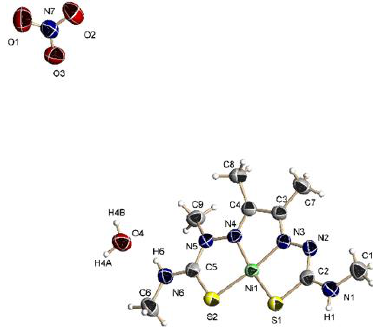
Figure 2. Molecular structure of 1 · H 2 O. Thermal ellipsoids at 50% probability level.